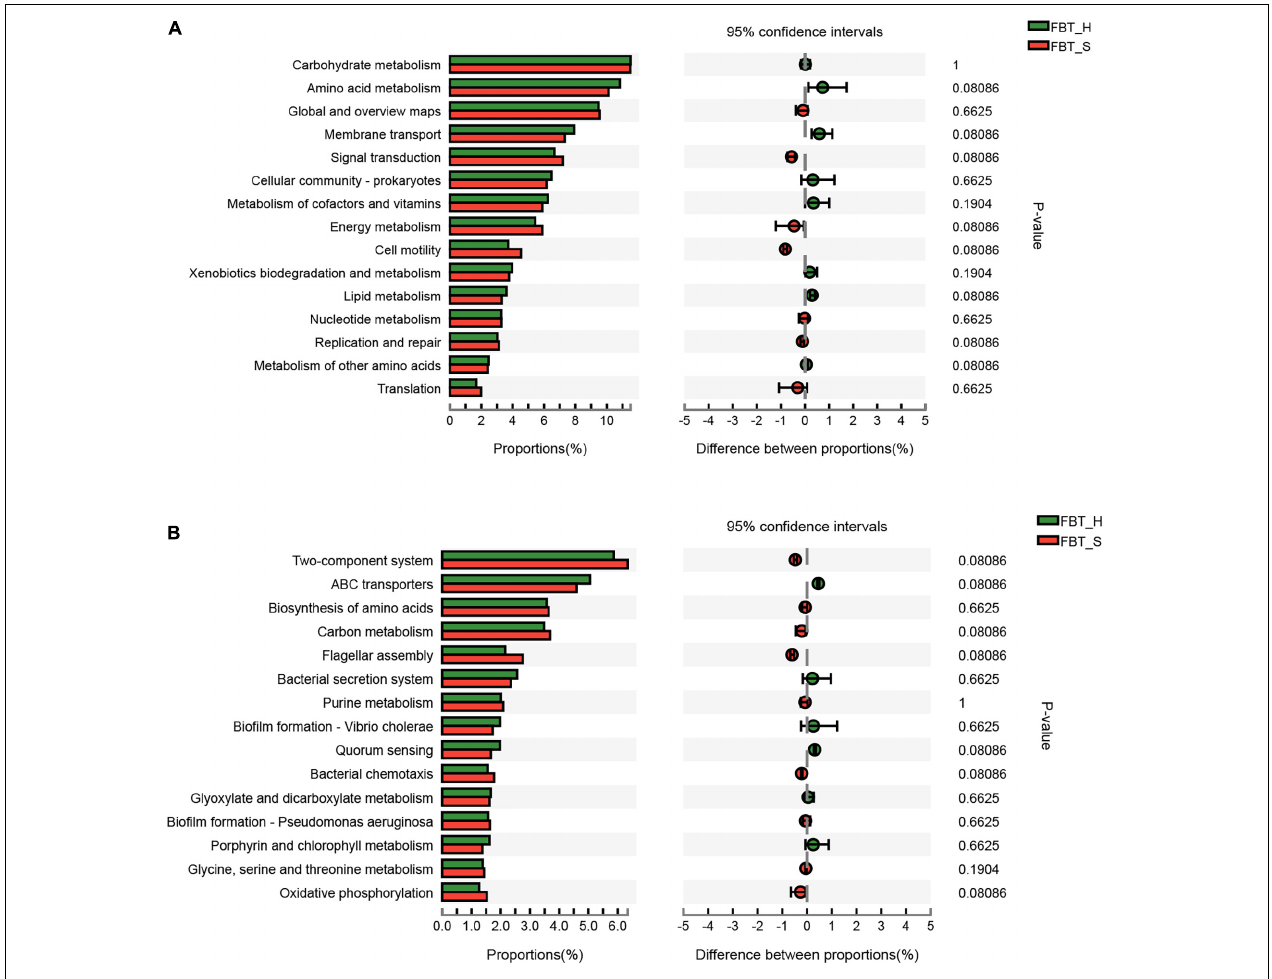
FIGURE 6 | Comparison of KEGG pathway level functions between FBT type communities. (A) KEGG pathway level 2 and (B) KEGG pathway level